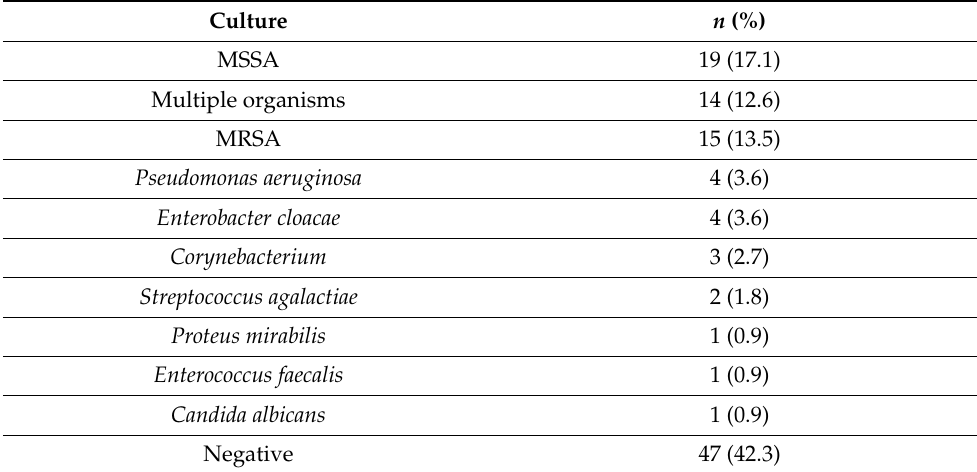
Table 4. Microbiological Cultures.